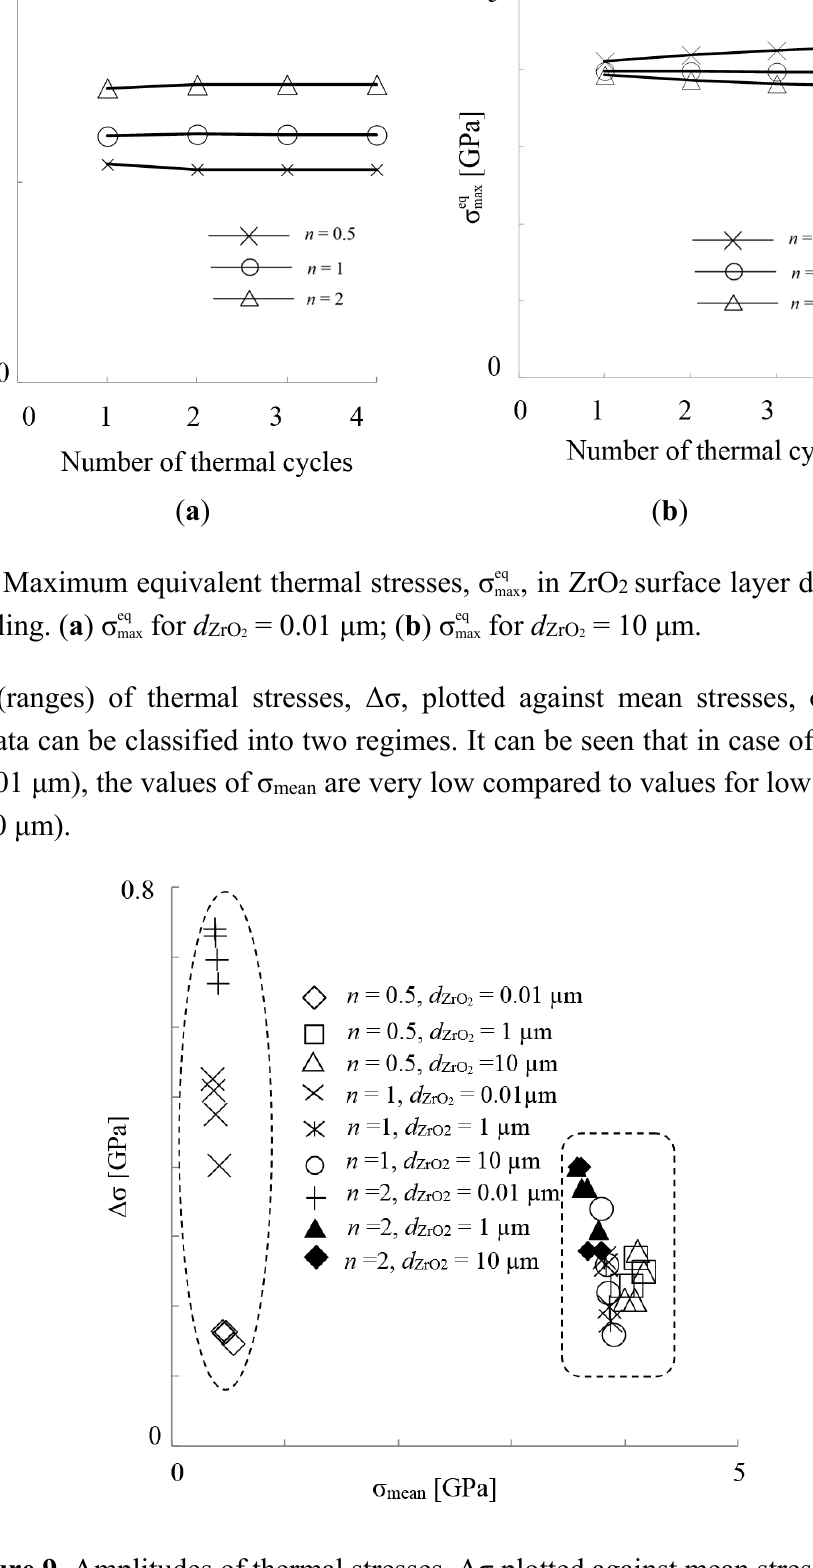
Figure 9. Amplitudes of thermal stresses, Δσ plotted against mean stress, σ mean . Δσ scatters over the wide ranges highly depending on compositional gradation patterns, n, in case of high creep rates of ZrO 2 , in which higher value of n leads to higher Δσ . Δσ − σ mean graph is in general used for examining the fatigue limits. σ mean value is high compared to Δσ value in case of low creep